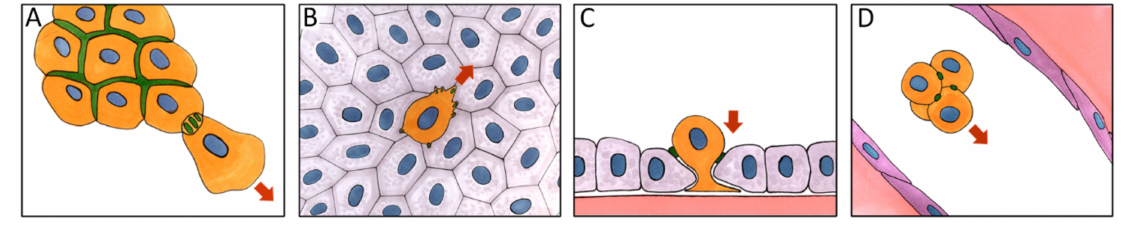
Figure 3. E-cadherin-based adherens junctions (AJs) facilitate cancer cell dissemination. ( A )—collective invasion. ( B )— migration over a monolayer of normal epithelial cells. ( C )—invasion of the monolayer of normal epithelial cells. ( D )—a circulating tumor cell (CTC) cluster traveling through circulation. Orange—cancer cells, grey—normal epithelial cells, purple—endothelial cells. Green—E-cadherin-based AJs, red arrows—direction of cell